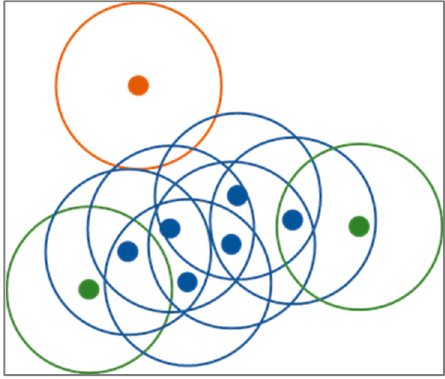
Figure 4. Diagram of DBSCAN clustering procedure with value three for the minimum neighboring points threshold. DBSCAN discriminates between core (blue), non-core (green), and noise (orange) points.